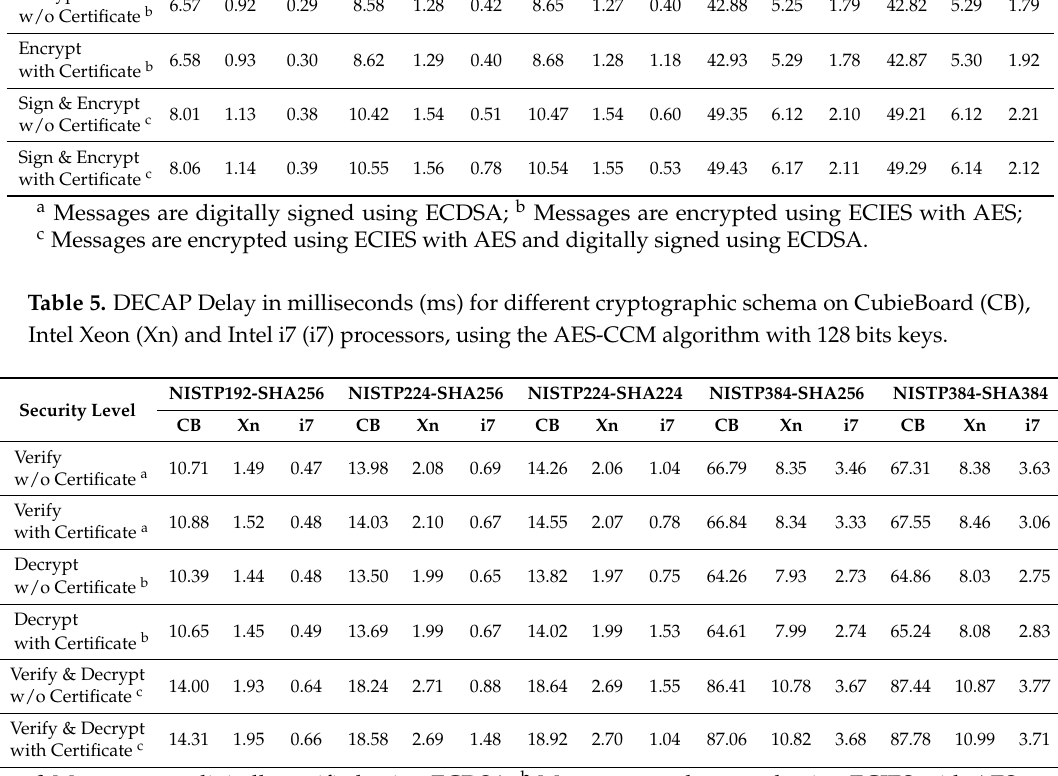
Table 4. ENCAP Delay in milliseconds (ms) for different cryptographic schema on CubieBoard (CB), Intel Xeon (Xn) and Intel i7 (i7) processors, using the AES-CCM algorithm with 128 bits keys. Security Level Sign 1.39 0.19 w/o Certificate a Sign 1.44 0.20 with Certificate a Encrypt 6.57 0.92 w/o Certificate b